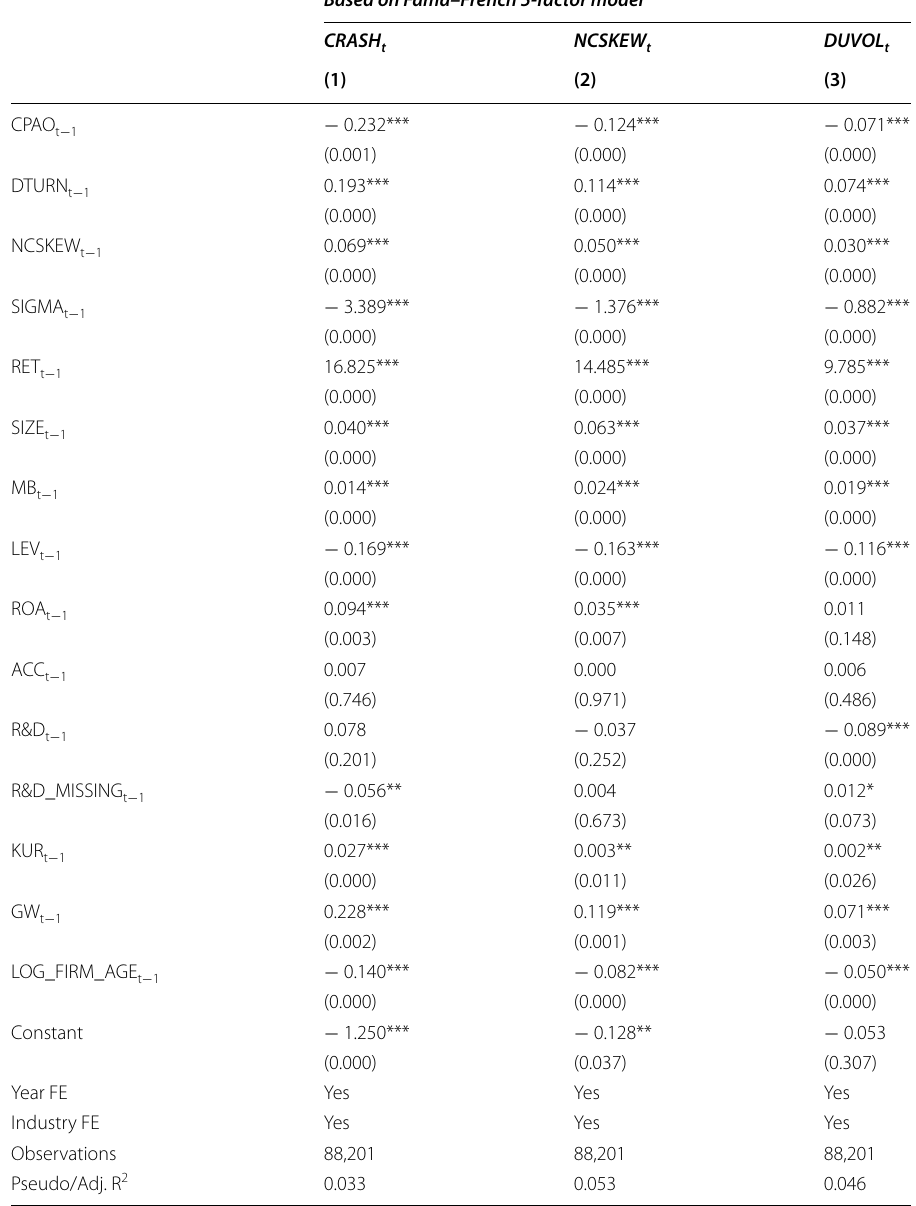
Table 9 Alternative crash risk measures based on Fama–French 5-factor